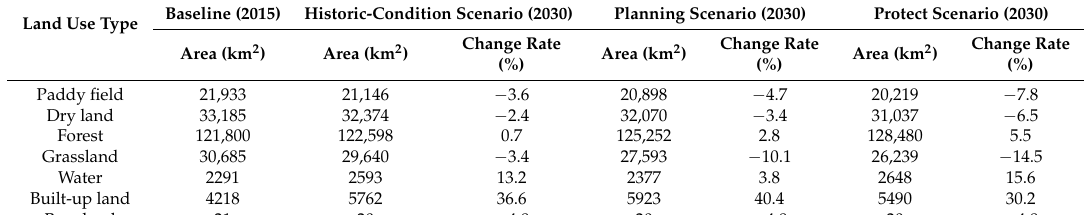
Table 7. Change of land use from 2015 to 2030 under different scenarios.